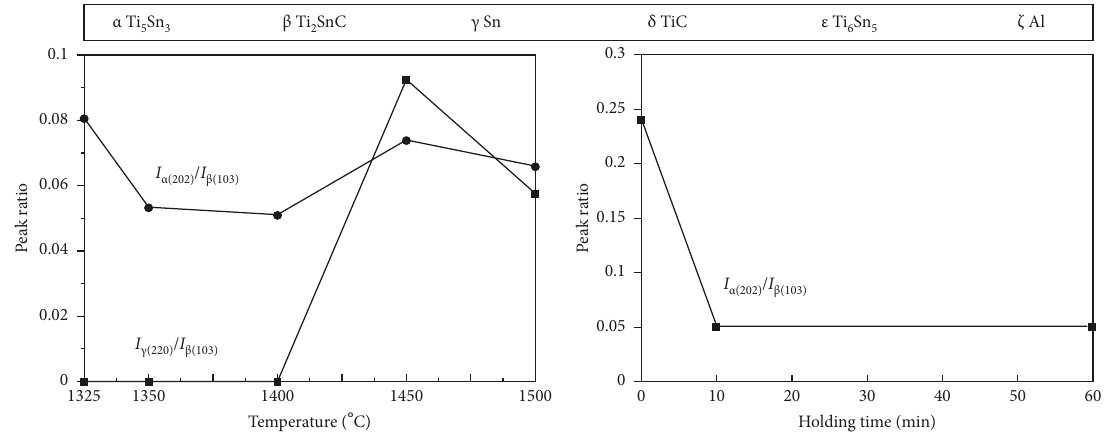
Figure 4: Effect of (a) sintering temperature holding time and (b) holding time on the peak ratio of Ti ratio of 2:1:0.2 :1 for Ti :Sn :Al